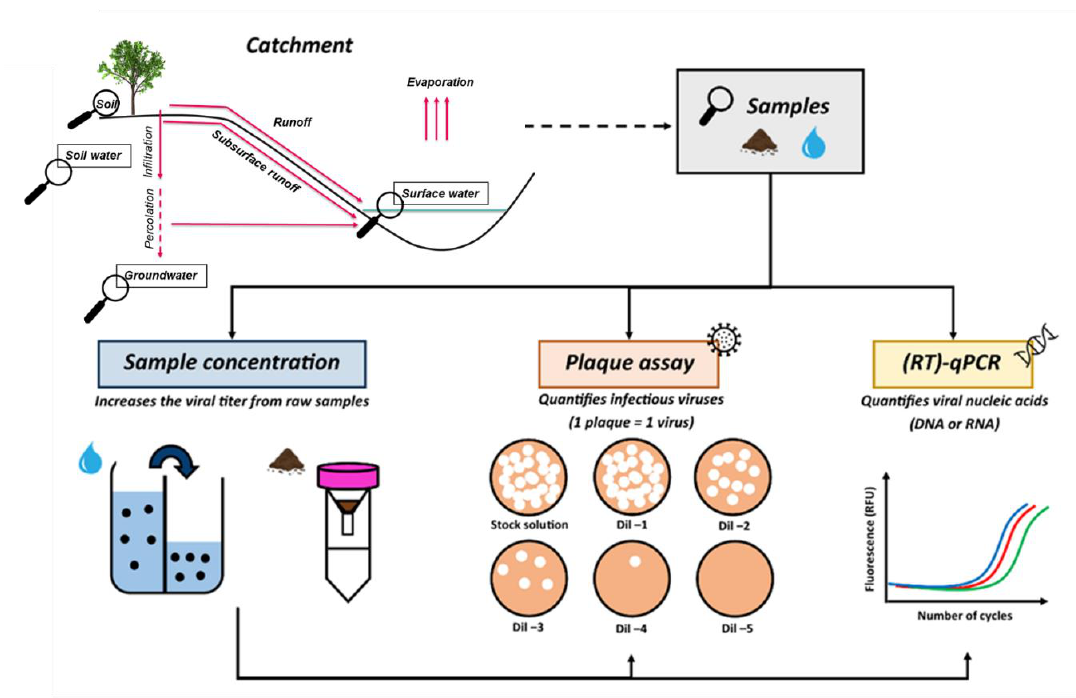
Figure 3. Methodology for the detection of bacteriophages from environmental samples. (Dil = di-